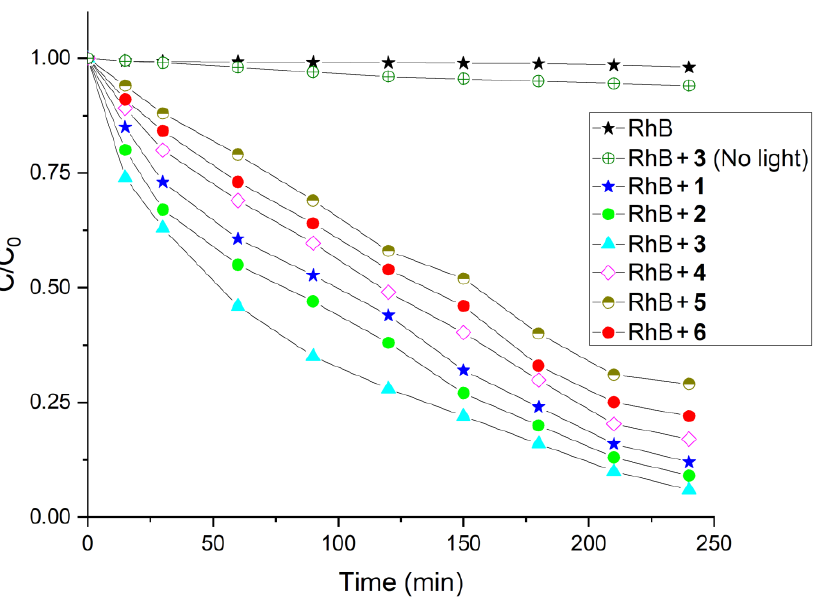
Figure 4. Photocatalytic degradation of RhB dye by six triads in aqueous solution (pH 7, tempera- ture 298 K) under visible light irradiation. 298 K) under visible light